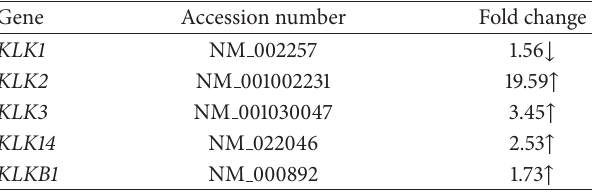
Table 2: Kallikrein-related peptidases regulated by SF in the Taqman 96-well plate array. Results are expressed as fold above control.